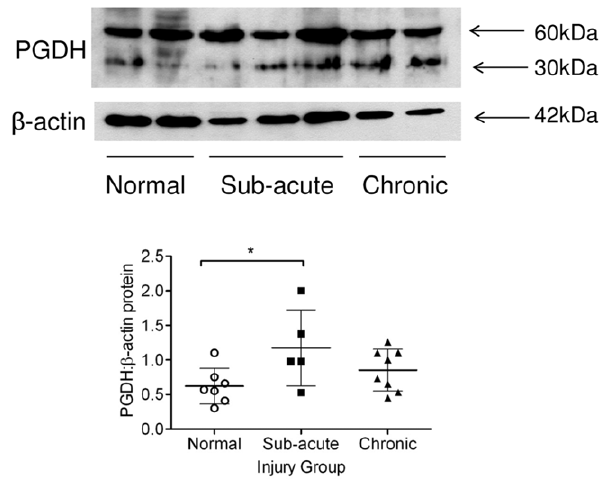
Figure 5. Representative Western blots illustrating expression of PGDH and b -actin in normal, sub-acute and chronic SDFT extracts. Monomeric (30 kDa) and dimeric (60 kDa) bands are shown for PGDH and a 42 kDa band for b -actin. Samples were loaded on a volume basis and the ratio of PGDH normalised to b -actin was calculated for each sample using band densitometric analysis. Graph shows densitometric analysis of western blots for PGDH in protein extracts prepared from normal (n=7) sub-acute (n=5) and chronic injured SDFTs (n=8). The densitometric values were normalized to levels of b -actin expressed in each sample. There was a significant increase in PGDH in sub-acutely injured tendon extracts compared to normals but this was not significantly different in the chronic injury group. * P , 0.05, ** P , 0.01. Mean values are shown, error bars denote standard deviation.